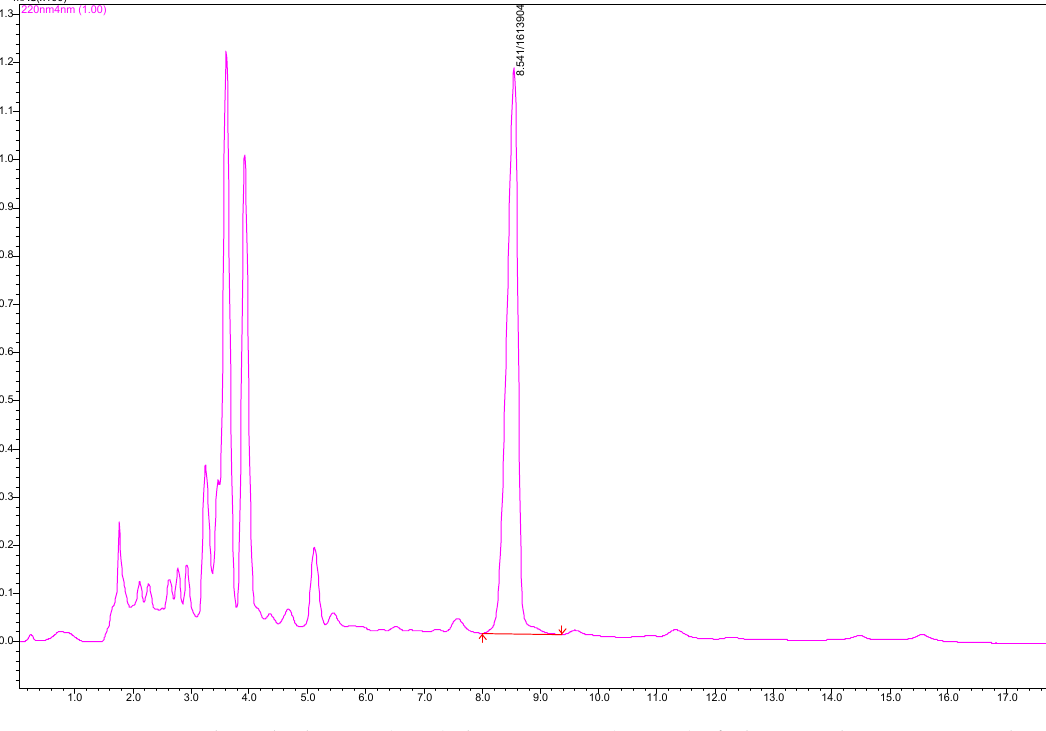
Figure 1. HILIC-photo diode array (PDA) chromatogram (220 nm) of a bee sample positive to oxalic acid (OA). Table 1. Regression parameters, limit of detection (LOD), limit of quantification (LOQ), recovery and repeatability validation